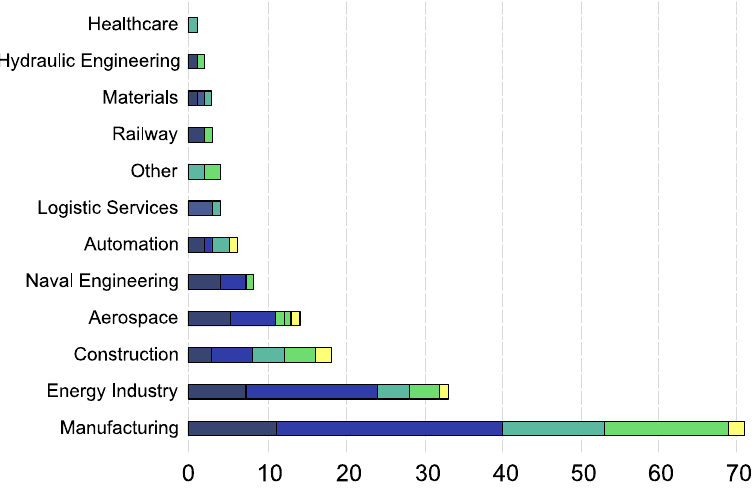
Figure 2. Distribution of publications on the Digital Twin across various fields, where PHM stands for Prognostic Health Management [53].